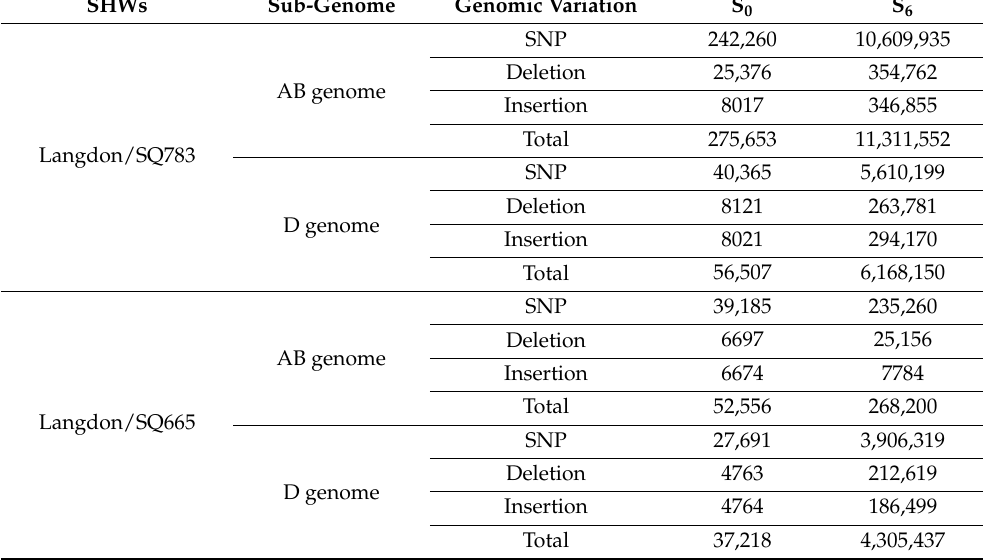
Table 1. Numbers of detected SNP/Indel between different generations of SHW and their parents ¶ . SHWs